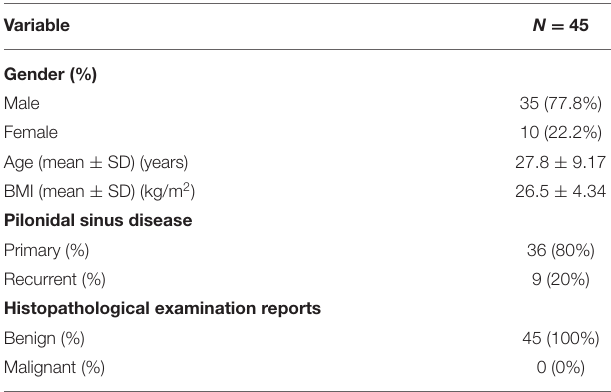
TABLE 1 | Demographics and clinicopathological characteristics of the patients.